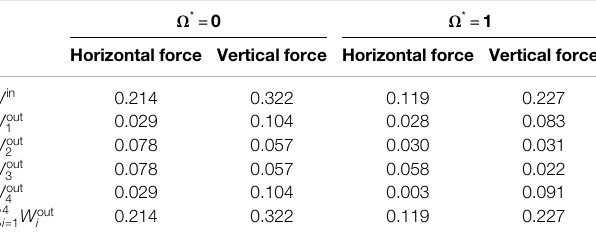
TABLE1| Valuesofenergy fl owsinthemicro-structuredlatticeduetoahorizontal or vertical force, when the effective gyricity is either Ω * (cid:1) 0 or Ω * (cid:1) 1. Ω * = 0 Ω * =